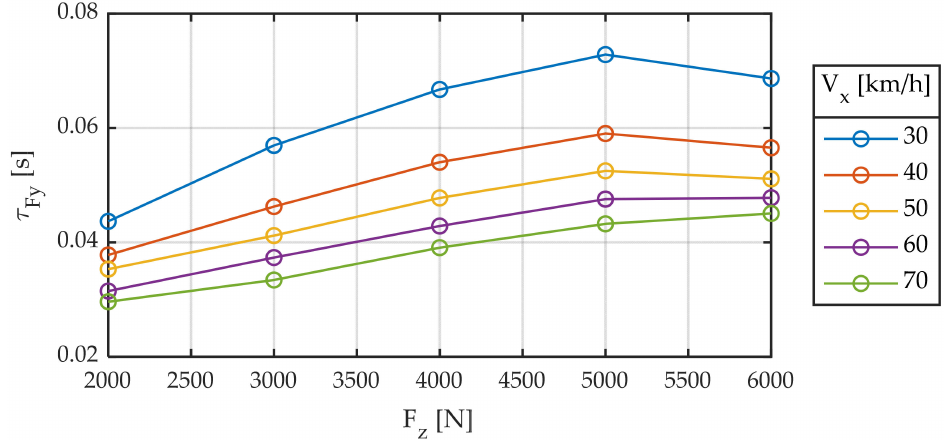
Figure 4. Relaxation length for different longitudinal speeds. Slip angle sweep ± 2 ◦ . Frequency 1.0 Hz.